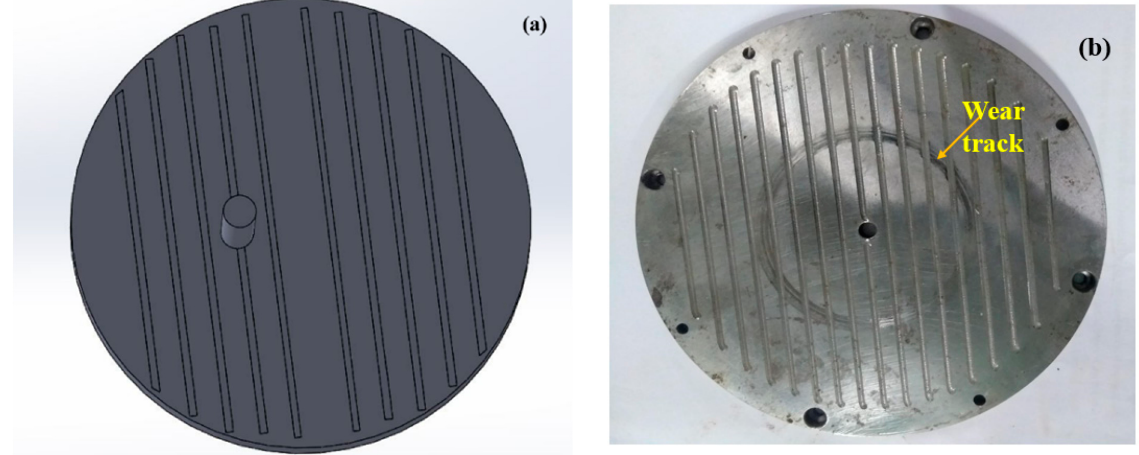
Figure 2. ( a ) Schematic arrangement of the pin on the perpendicular-groove-textured disc, and ( b ) wear track obtained on the textured disc.